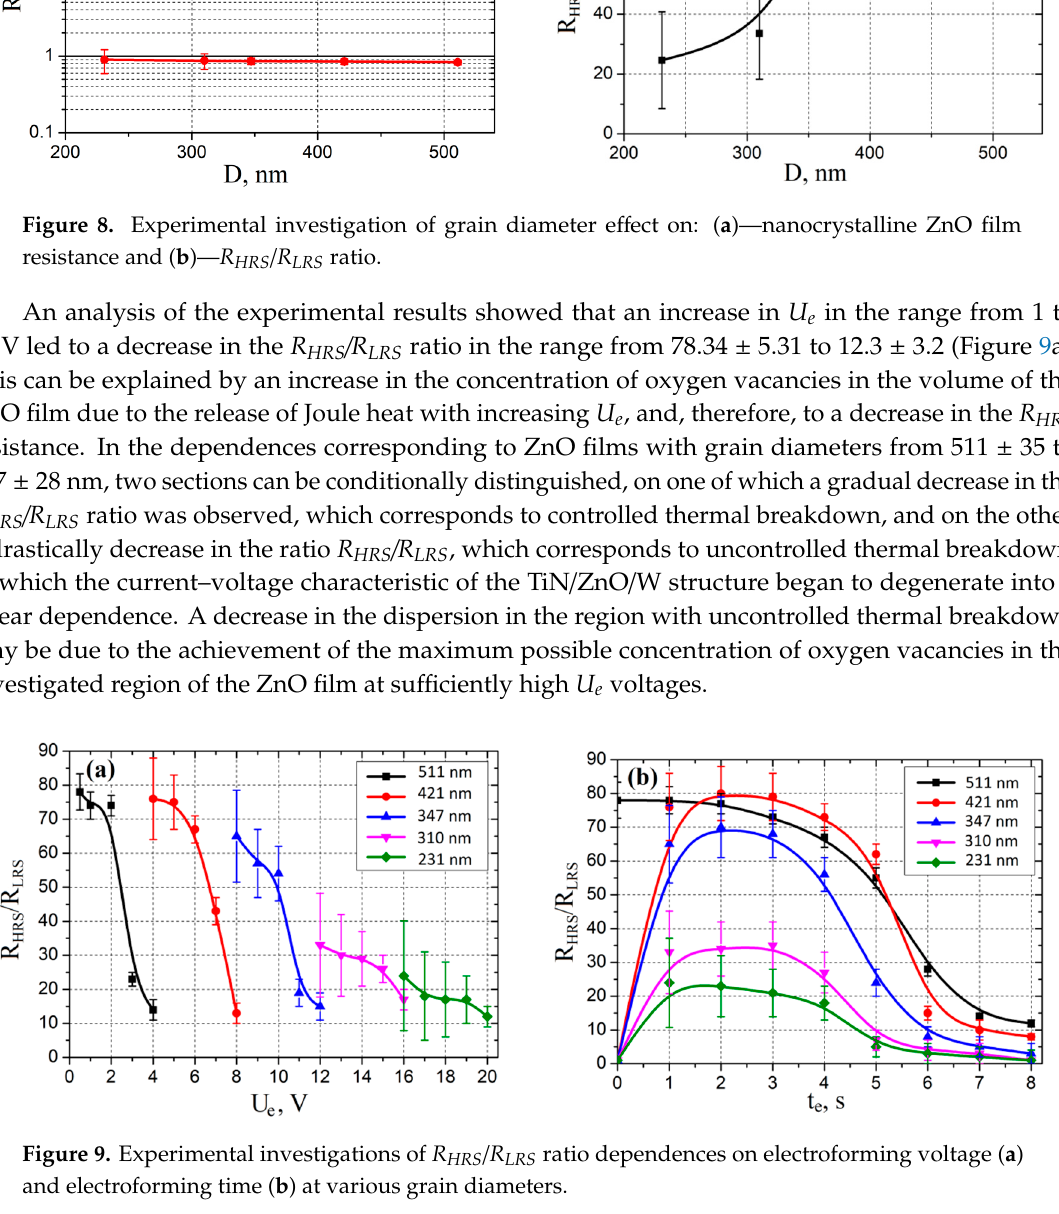
Figure 8. Experimental investigation of grain diameter effect on: ( a )—nanocrystalline ZnO film resistance and ( b )— R HRS / R LRS ratio.